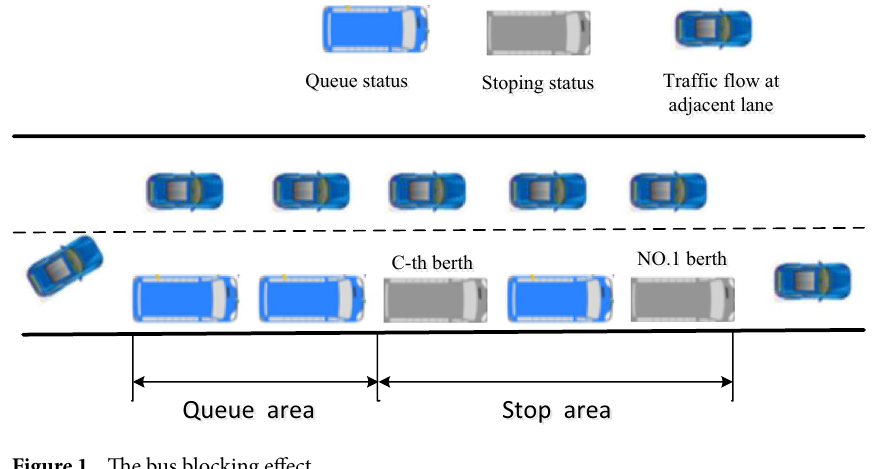
Figure 1. The bus blocking